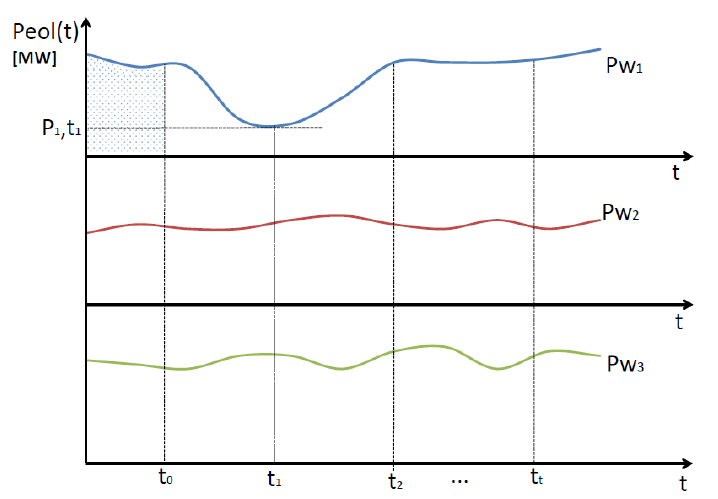
Figure 2. Simplified scenario of NCRES participation in a restoration